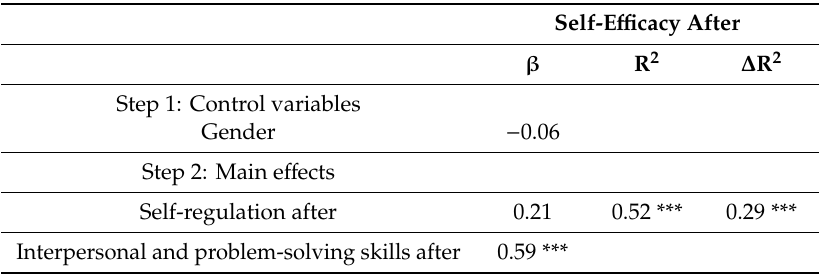
Table 4. Hierarchical regression analyses predicting self-e ffi cacy after interaction.